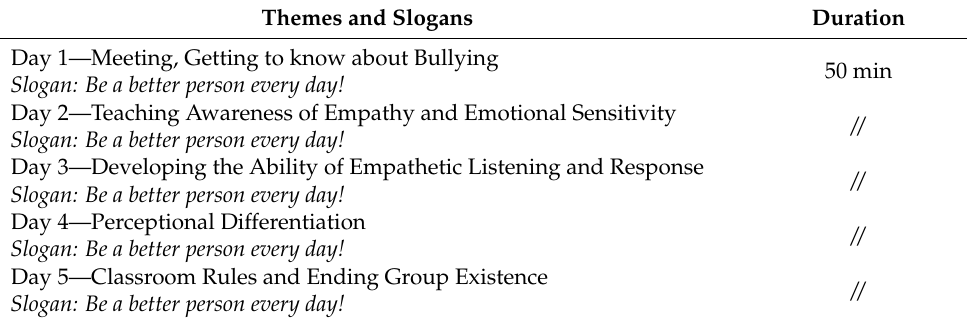
Table 2. The sessions in the intense empathy training program. Themes and